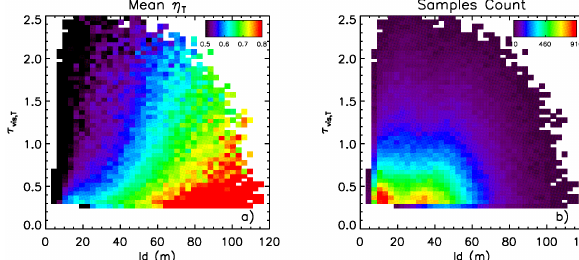
Figure 9. Two-dimensional histogram of multiple scattering factor η T and (a) temperature T c and (b) equivalent diameter D eq . The color code is the number of samples. The median and mean val- ues against T c are the black solid and dashed lines, respectively. In Fig. 9a, the horizontal red dotted dashed line shows the mean value of η T overall (0.601). The dotted lines indicate values discussed in the text. Same data set as in Fig. 8, all clouds combined.